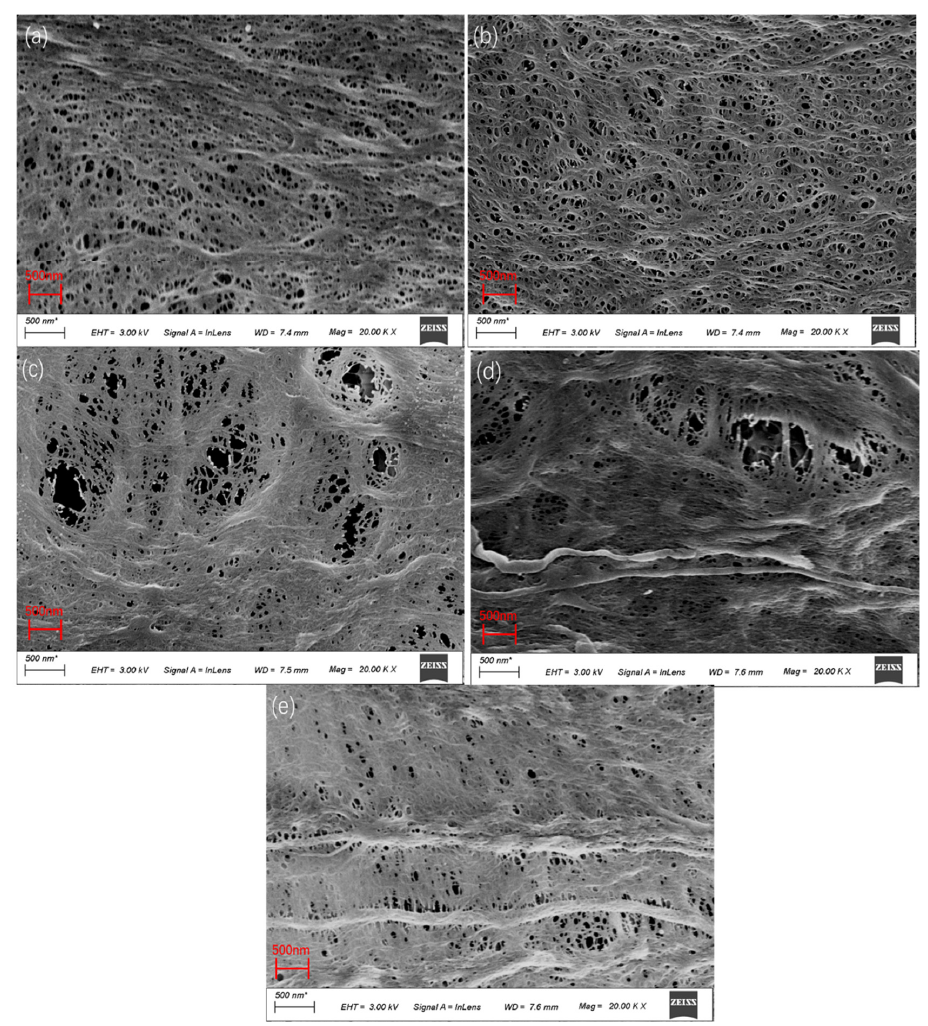
Figure 5. SEM surface morphology of PVDF/PEI blend membrane. ( a ) PI0, ( b ) PI1, ( c ) PI2, ( d ) PI3, ( e ) PI4.